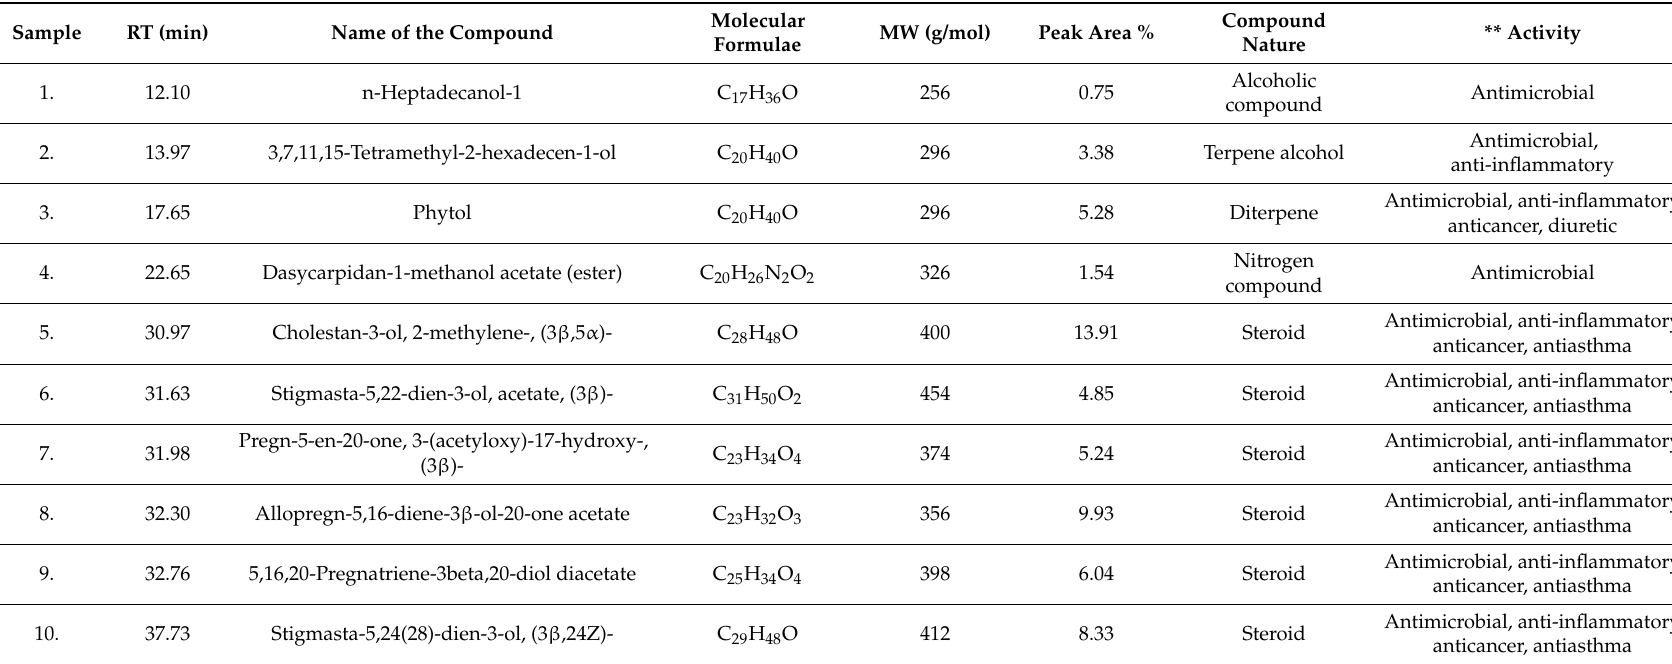
Table 4. Bioactive compounds identified in ethanolic fractions of U. prolifera by GC–MS/MS